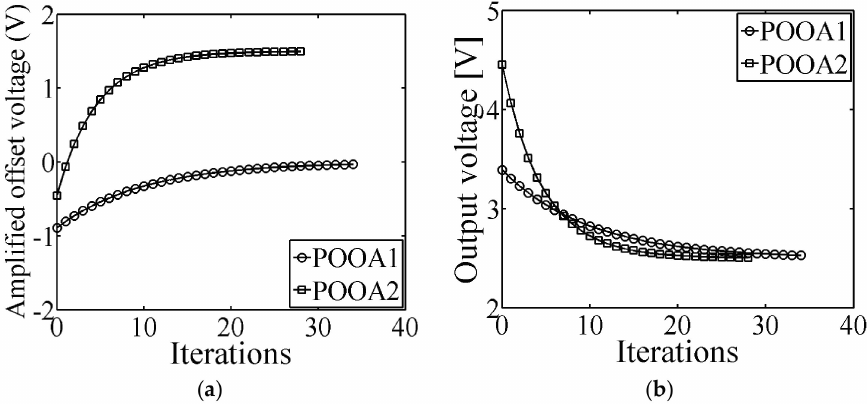
Figure 10. Test results of the programming performance. ( a ) The amplified offset voltage of both POOAs while the programming system is running. The error amplifier’s gain is 1000 for POOA1 and 100 for POOA2; ( b ) The LMS-algorithm error signal behavior.